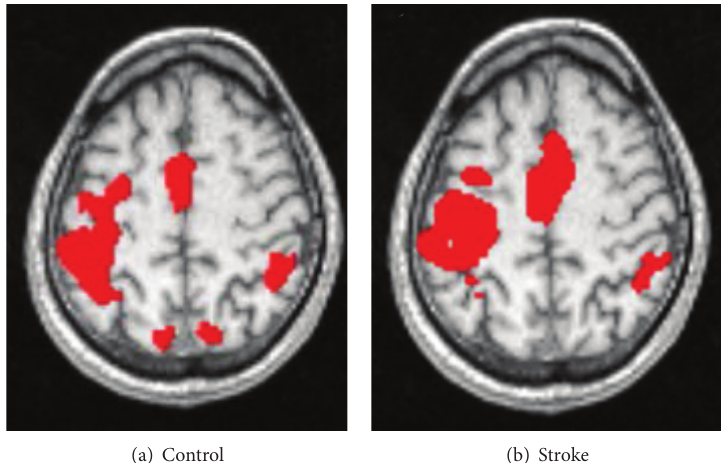
Figure 1: fMRI activation during grasp preparation task: average maps for healthy control group (a) and stroke group (b). Tested arm was contralateral to the hemisphere on the left side of each image.